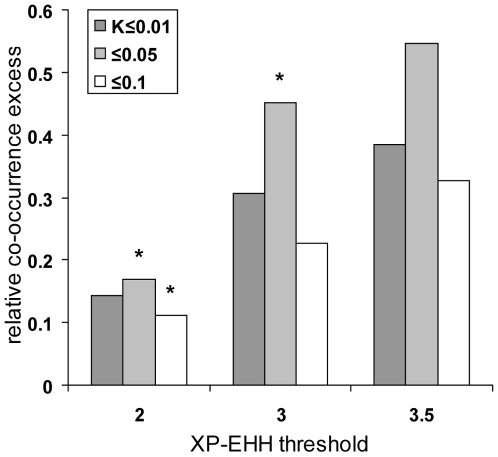
Co-occurrence between non-human primates selective sweep candidates
and XP–EHH worldwide human populations selective sweep
candidates.The co-occurrence test was applied using K in
chimpanzee, orangutan and macaque to assign candidate genes on the one
hand (Figure S5, group 1) and increasing XP-EHH values at genomic
centers of genes tested in seven human populations on the other hand
[5] (Figure
S5, group 2). The histogram represents the relative
co-occurrence excess obtained using 9,873 orthologous genes (observed
score/expected score – 1) for XP-EHH values increasing from 2
to 3.5 with recombination and gene density being accounted for (see
Methods). The excess of
co-occurrence observed is lower for K≤0.01 than
for K≤0.05, likely reflecting a loss of power to
detect hotspots at the most stringent thresholds. *:
co-occurrence test P≤0.05. **:
P≤0.01. ***:
P≤0.001.